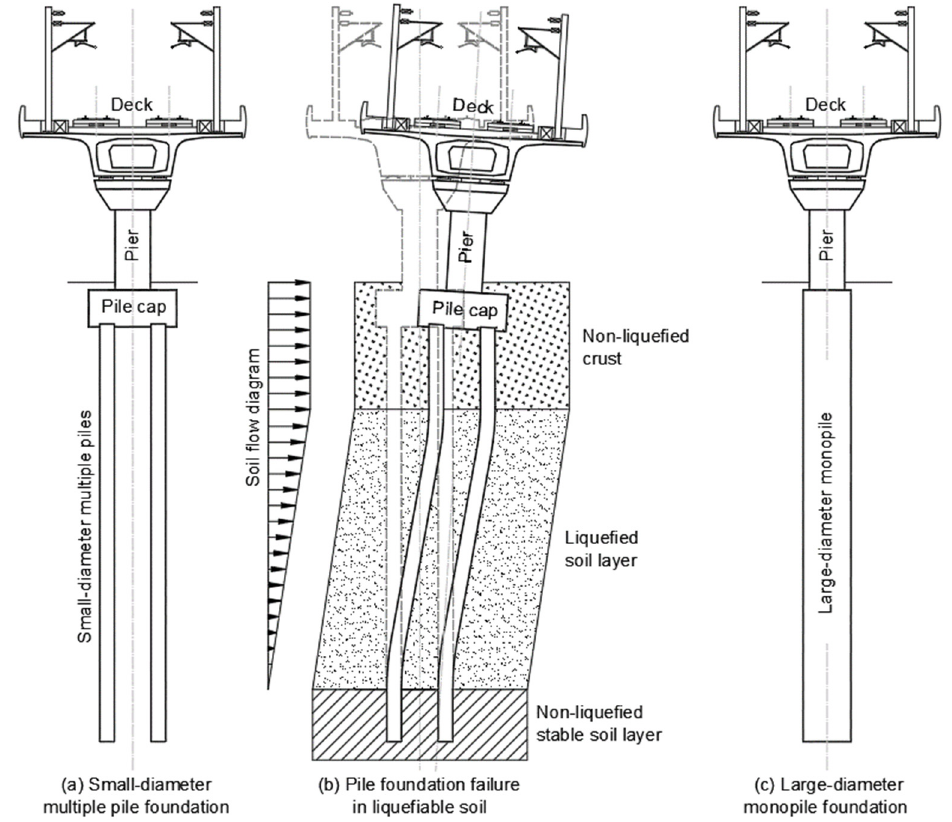
Figure 2. Innovation of HSR bridge